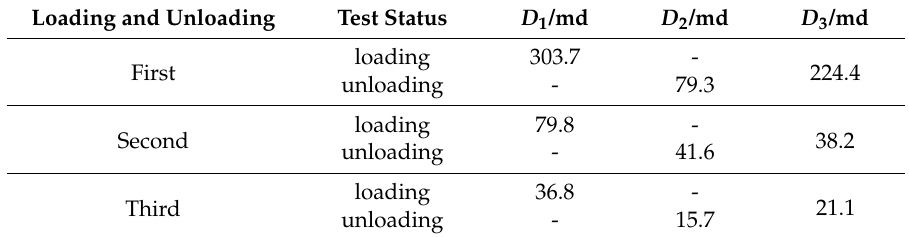
Table 3. Calculated values of D 1 , D 2 and D 3 of coal samples under cyclic loading and unloading conditions. Loading and